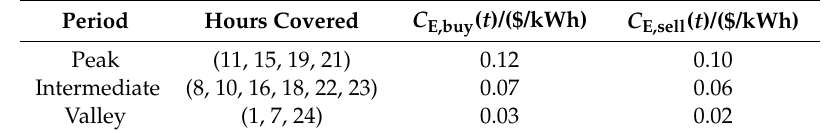
Table 2. TOU price [33].